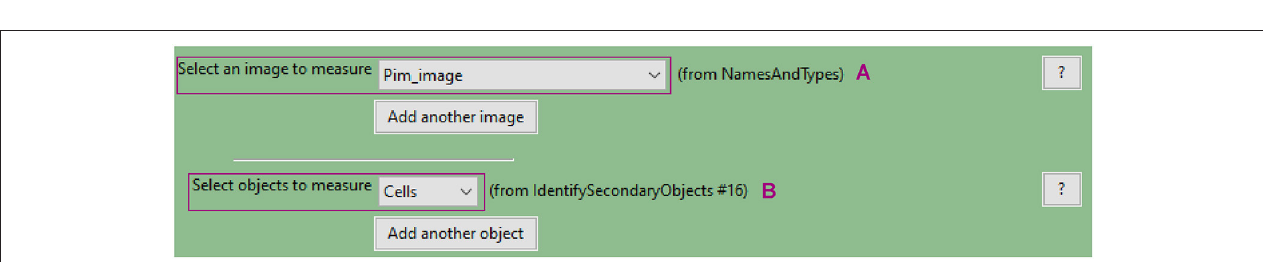
confocal fluorescence images were taken at 0, 24, and 48